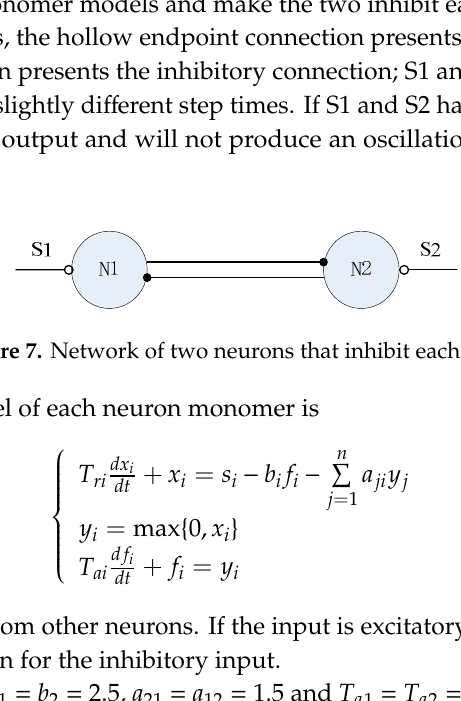
Figure 6. Step response of the neuron model.